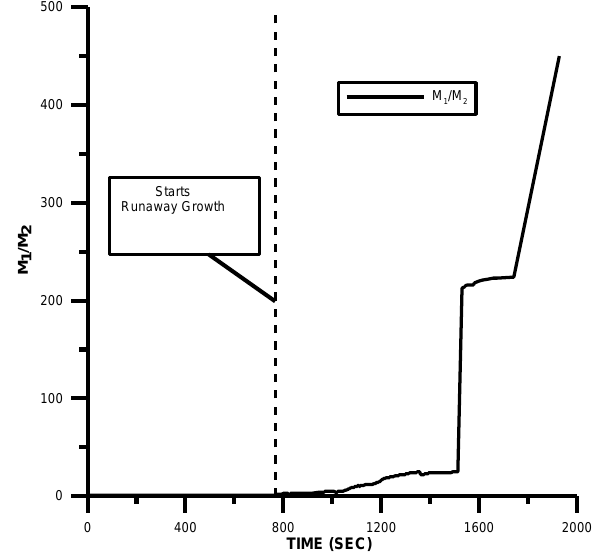
Fig. 8. Time evolution of 1 2 M M (ratio between the largest and the second largest droplet) for one of the realizations of the stochastic process for the turbulent case.